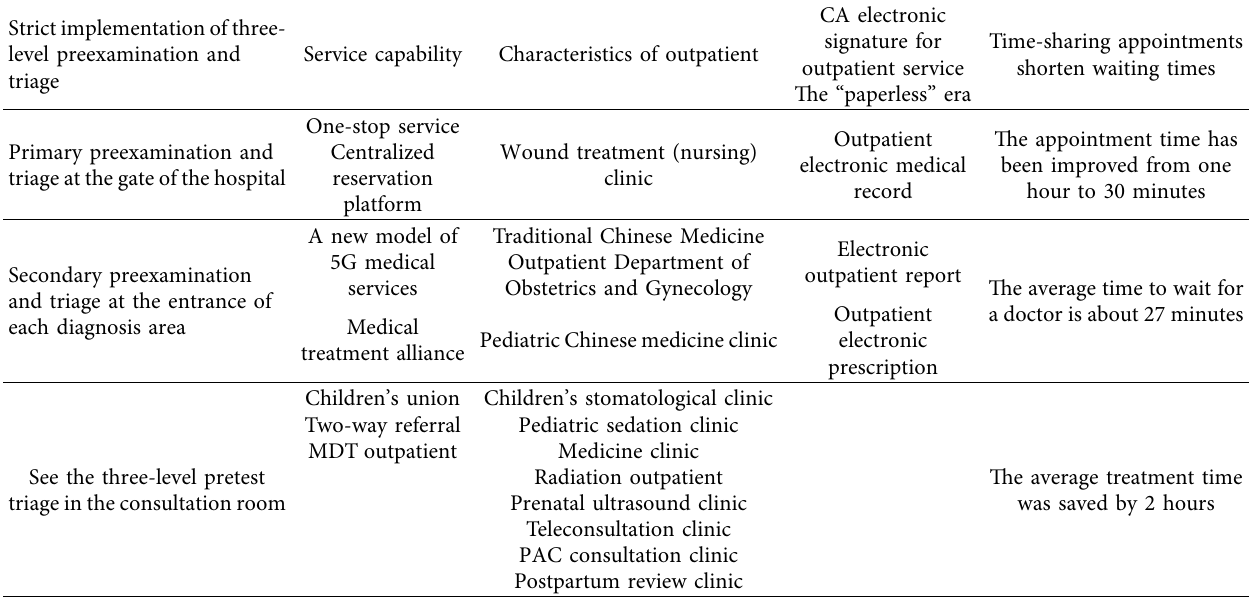
Table 1: Continuing to enhance service capacity and improve patient